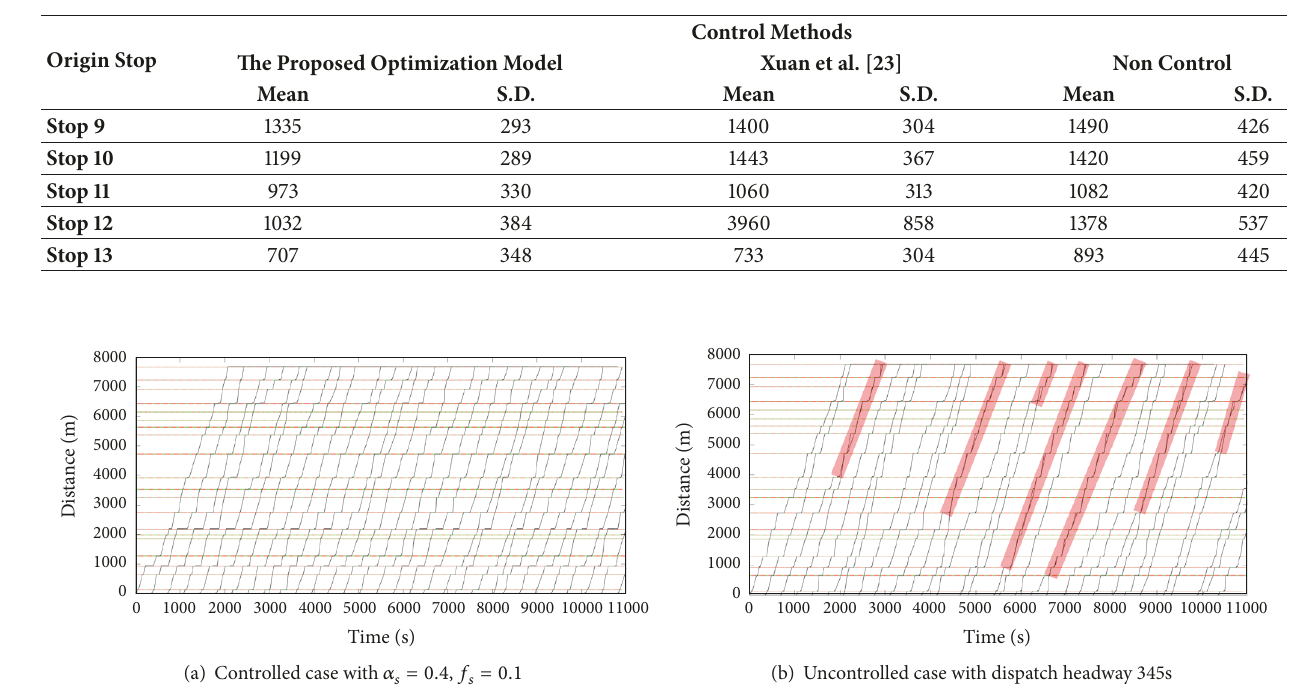
Table 5: Comparisons of the Mean Value and Standard Deviation of Passenger Travel Time under Different Control Methods (Unit: seconds).